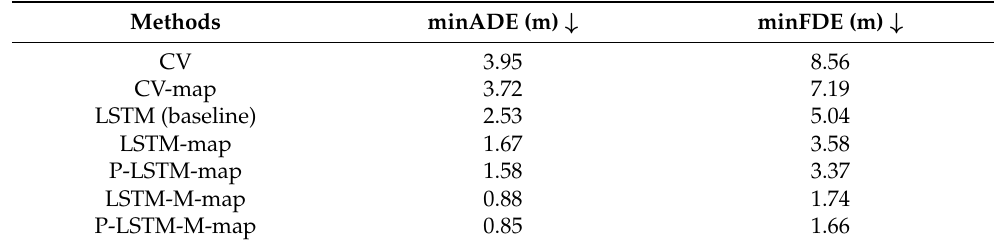
Table 4. Comparison of multi-modal vehicle trajectory prediction methods on Argoverse